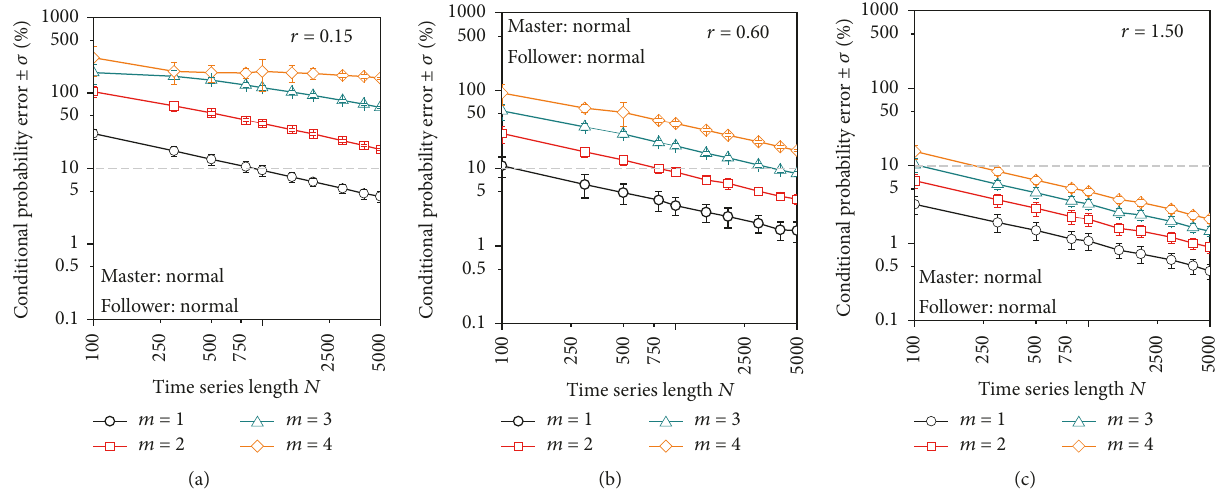
Figure 3: The relative conditional probability error [ % ] in artificial data for a typical threshold value 𝑟 = 0.15 (a), for a higher threshold 𝑟 = 0.60 (b), and for an unusually high threshold 𝑟 = 1.50 (c); the gray dashed horizontal line marks 10% error; results are presented in a log-log plane as mean ± 𝜎 (standard deviation). Artificial master and follower series are both normally distributed.